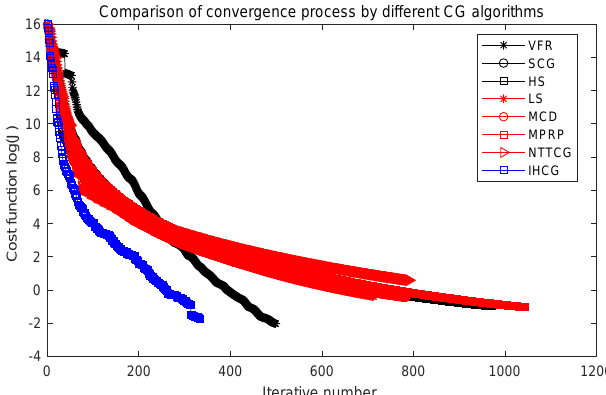
Figure 6. Comparison of convergence process log ( J ) by different CG algorithms.